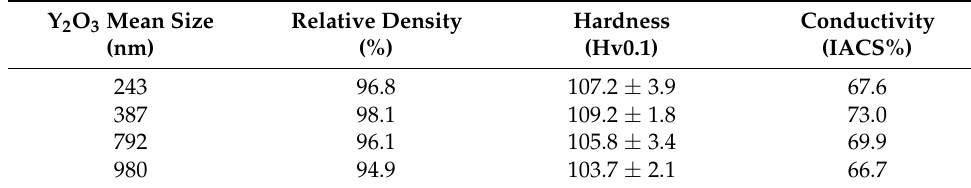
Table 1. Physical properties of Ag/Y 2 O 3 sintered compacts.